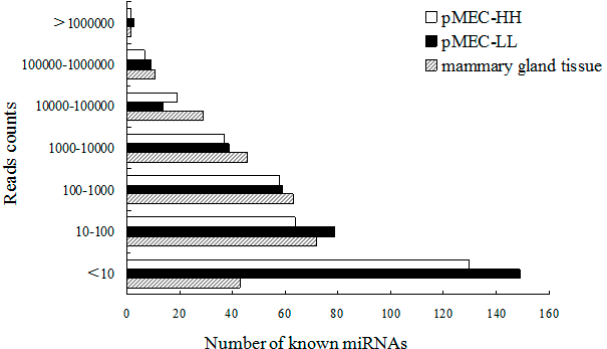
Figure 1. Sequencing reads distribution of known miRNAs in pMECs and mammary gland tissues. The